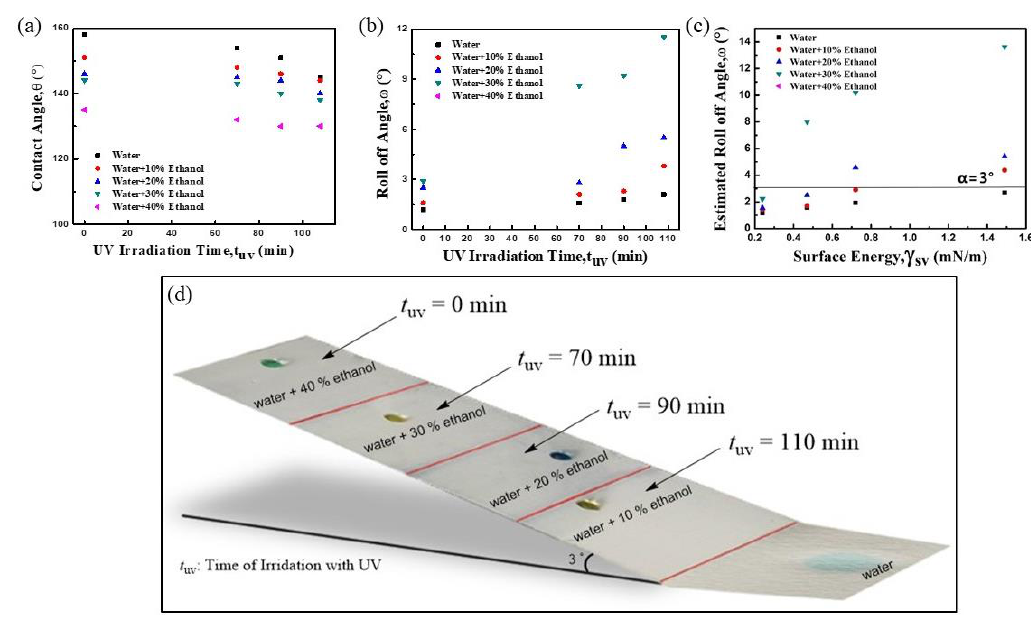
Figure 2. ( a ) Apparent contact angles of droplets on Slide No. 5, decreasing with increasing ultraviolet (UV) irradiation time. ( b ) Measured roll-off angles of 10 μL ethanol solution droplets on the slide increased faster than those of 10 μL water droplets with increasing UV irradiation time. ( c ) Estimated roll-off angles of various 10 μL droplets on the slide with different solid surface energies. ( d ) Schematic showing the sorting of 10 μL droplets using the slide tilted at 3° with four areas of different surface energy.